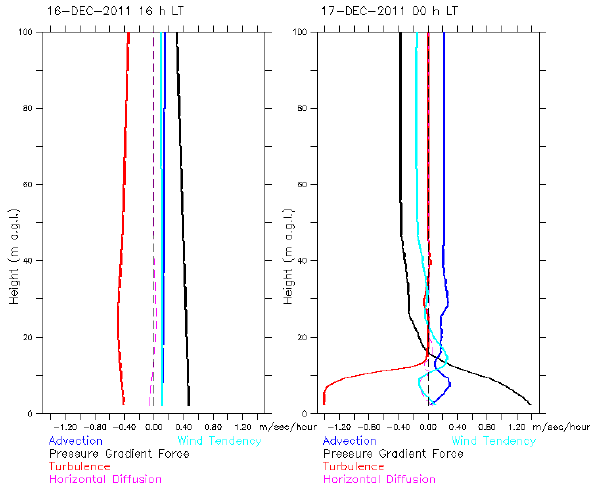
Figure 6. Vertical profiles of the contributions to the wind speed of PGF, advection, turbulence and horizontal